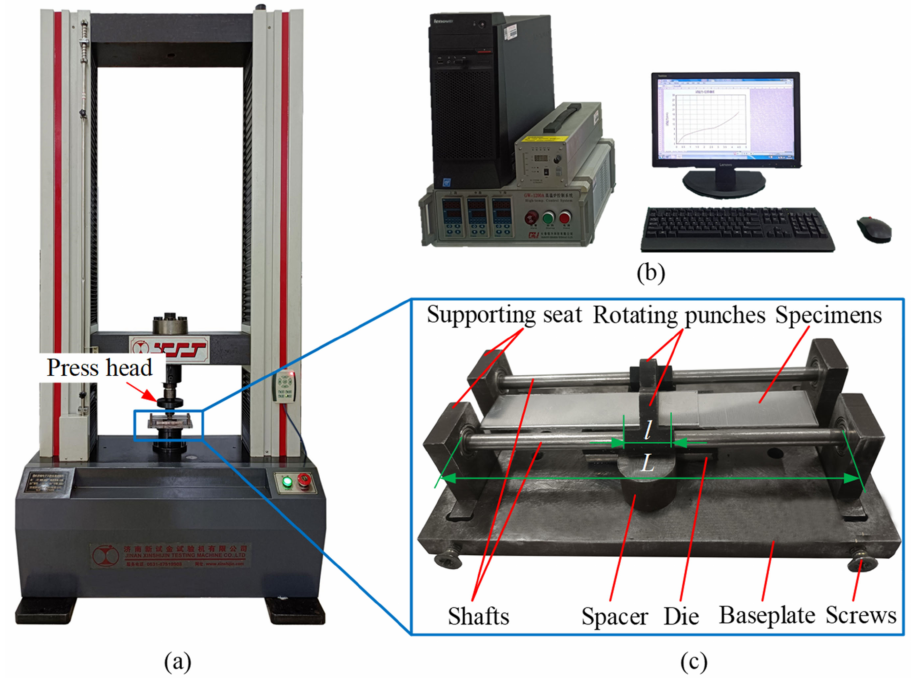
Figure 2. The RCP joining experimental platform. ( a ) Power system, ( b ) data acquisition system and ( c ) experimental